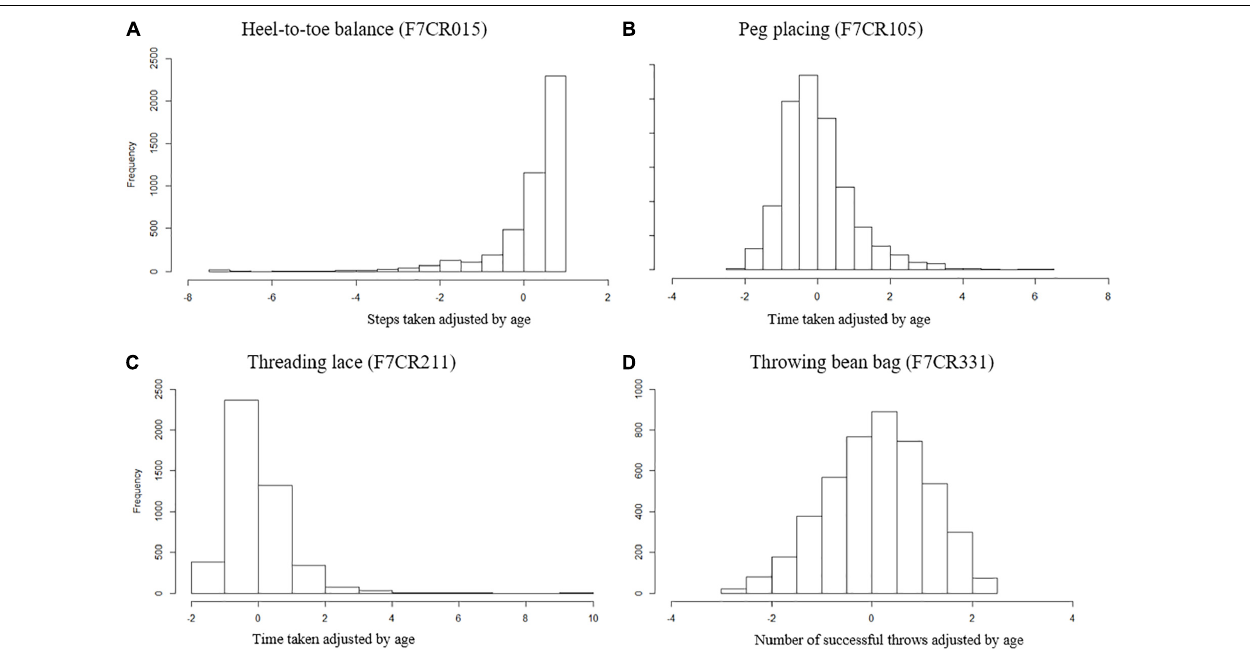
FIGURE 1 | Distribution of MABC test items age adjusted. (A) Heel-to-toe walking (F7CR015) showing the number of steps taken (high score denotes good performance). (B) Placing pegs (F7CR105) showing the time taken to complete the task (low score denotes good performance). (C) Threading lace task (F7CR211) showing the time taken to complete the task (low score denotes good performance). (D) Throwing bean bag (F7CR331) showing the number of throws that successfully hit the target (high score denotes good performance).